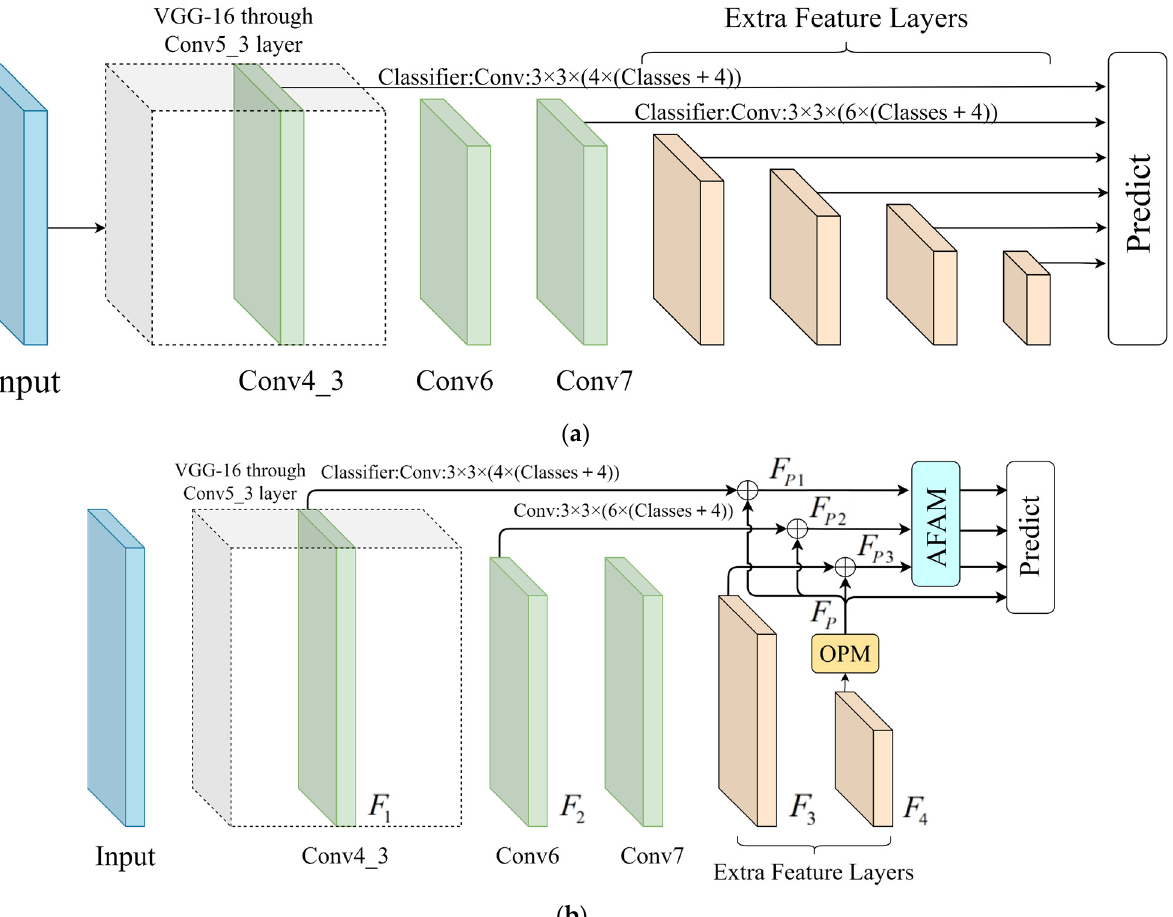
Figure 1. ( a ) Overall architecture of SSD. ( b ) Overall architecture of AFADet.